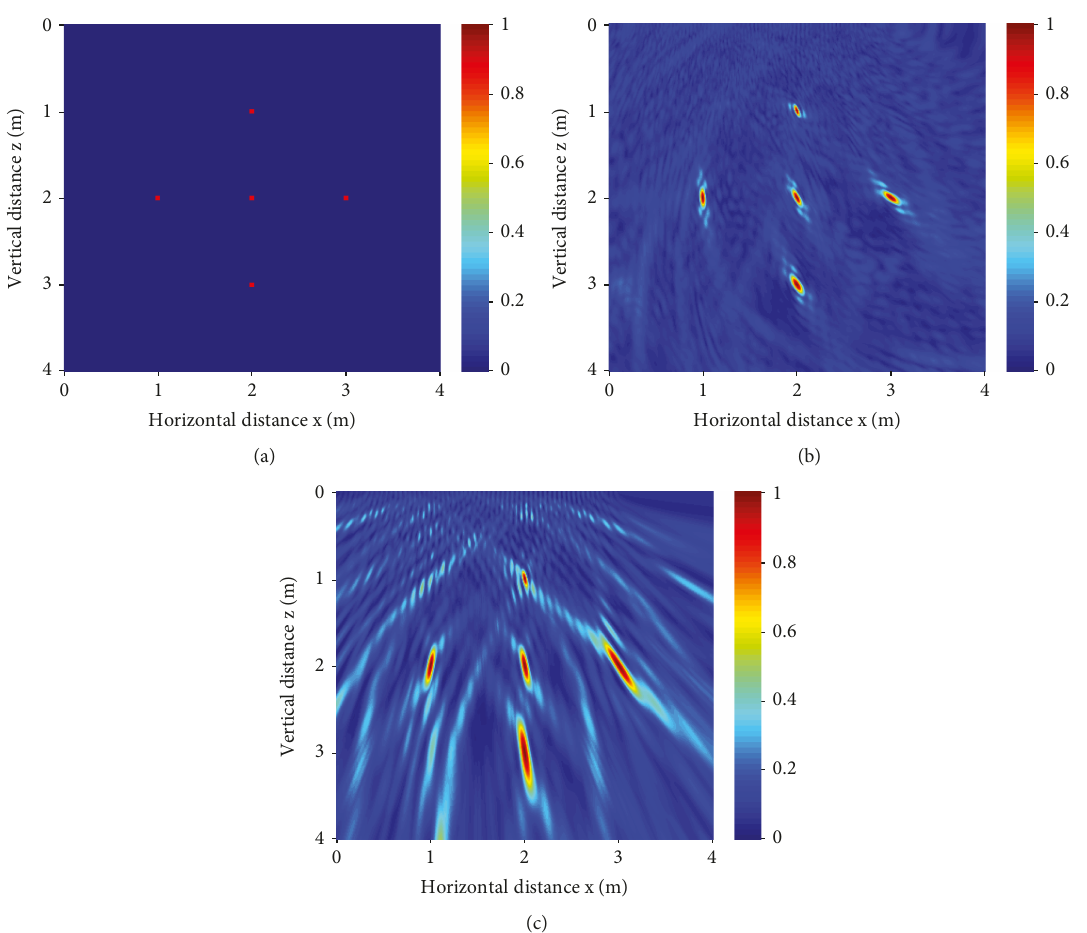
Figure 4: Multitargets detection: (a) actual position of targets, (b) FDA-MIMO radar, and (c) conventional MIMO